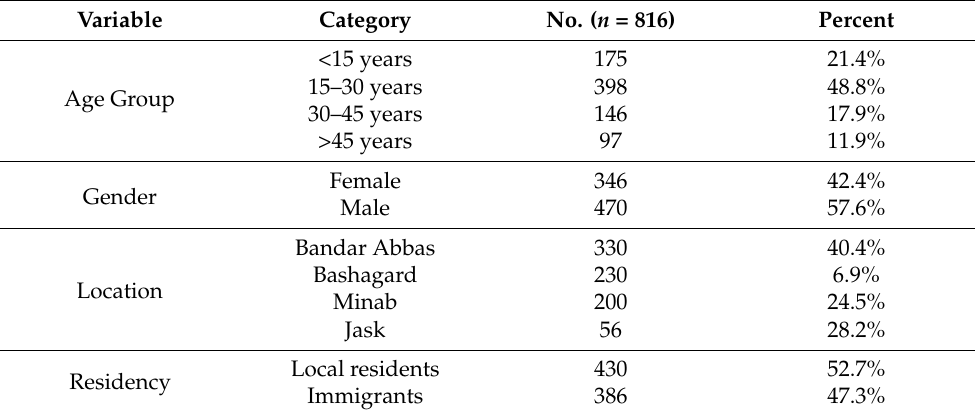
Table 1. Demographic characteristics of the participants in an asymptomatic malaria study.